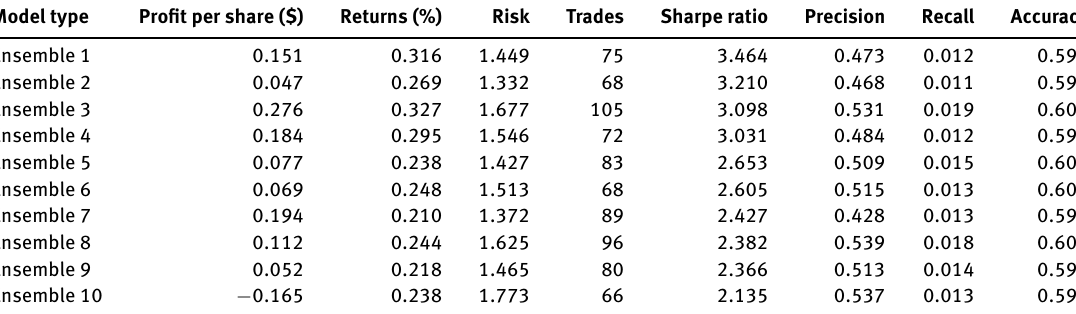
Table 13: 60-Min Ensemble of Regression Models Metrics on Testing Set. Model